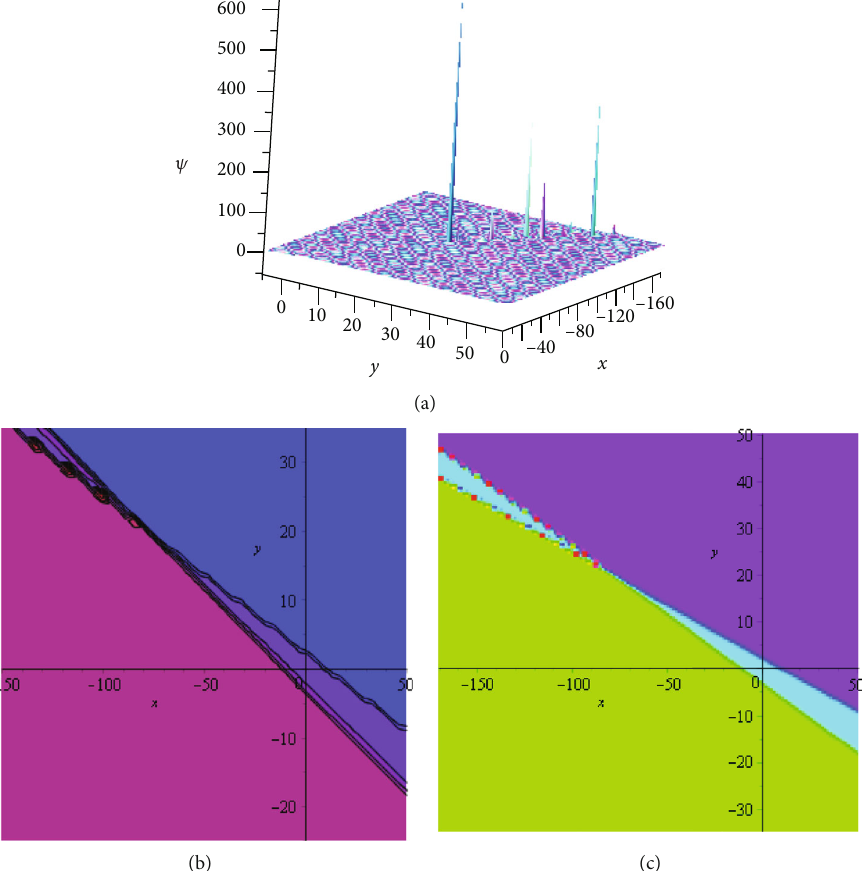
= : 2, Ω = 2, δ = 1, δ = 1 : 3, 5 9 1 2